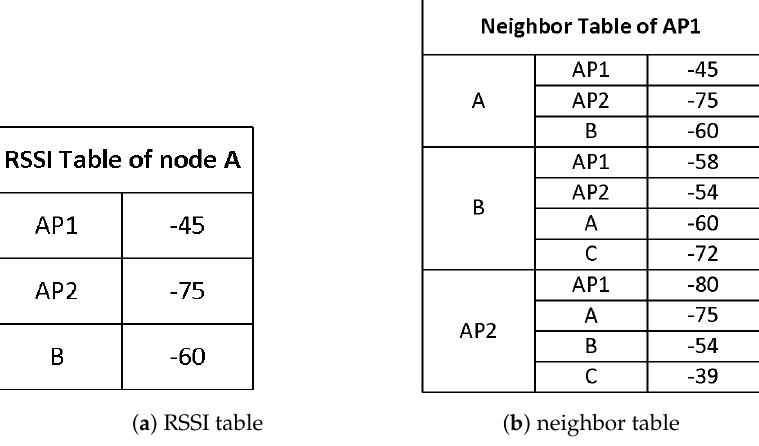
Figure 3. An RSSI table ( a ) and a neighbor table ( b ) used in measurement-based dynamic CST control. The RSSI table maintains average RSSI values for each of the neighbors. Also, the RSSI tables are periodically exchanged between neighboring nodes. Whenever a node receives an RSSI table from the neighbor, it updates the neighbor table which records the RSSI table of each